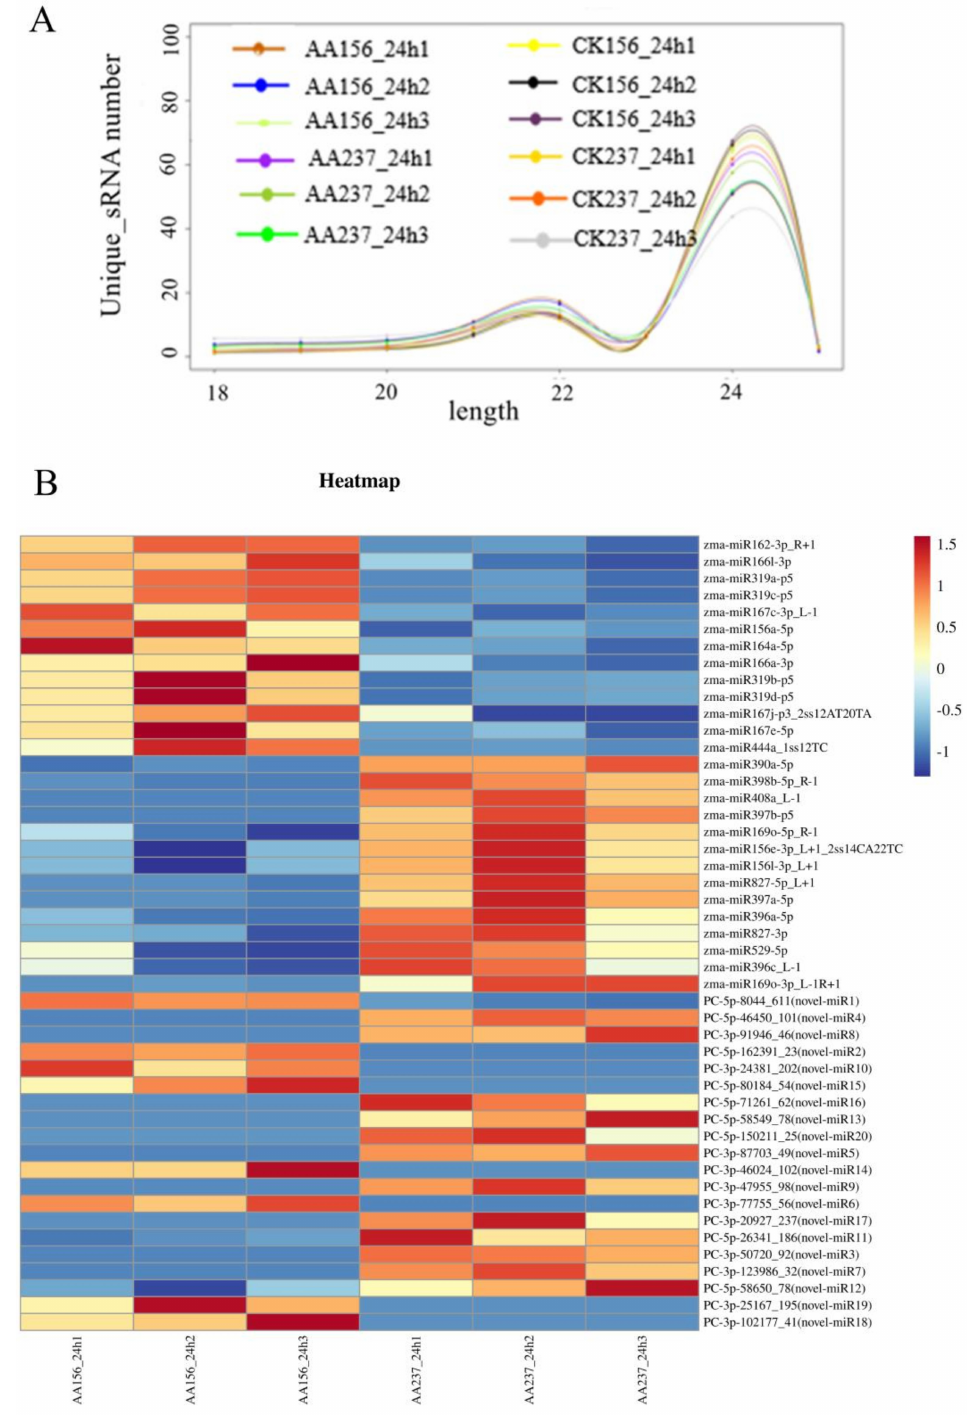
Figure 2. Summary of miRNA sizes and differentially expressed miRNAs and the number of identified known miRNAs. ( A ) The size distribution of unique sRNAs. ( B ) Differential expression heat maps of known miRNAs and putative miRNA s in maize. R+n means that there are n more bases on the right end of the miRNA included in the miRBase, R − n means that there are n fewer bases on the right end of the miRNA included in the miRBase, L+n means that there are n more bases on the left end of the miRNA included in the miRBase, 2ss12AT20TA means that the 12th base T is replaced by A (ss, substitution), and the 20th base T is replaced by A, a total of 2. New miRNAs are labeled with PC (Predicted